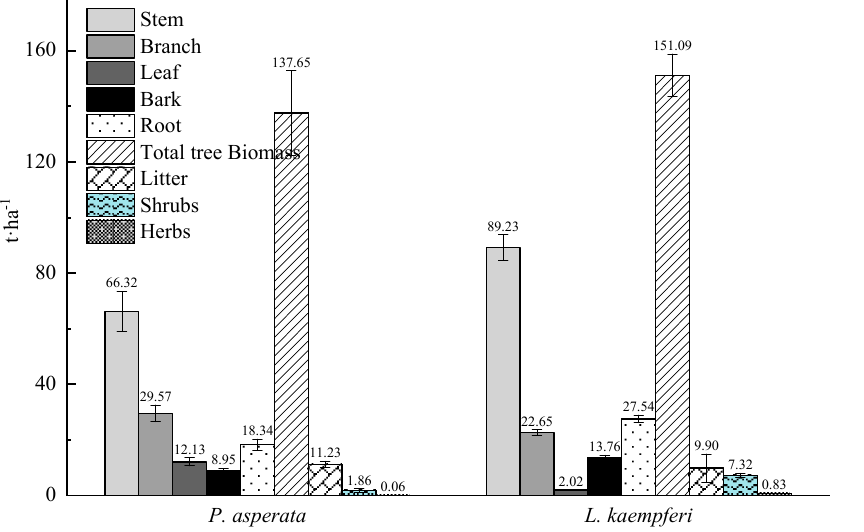
Figure 4. Biomass of two typical forest ecosystems.